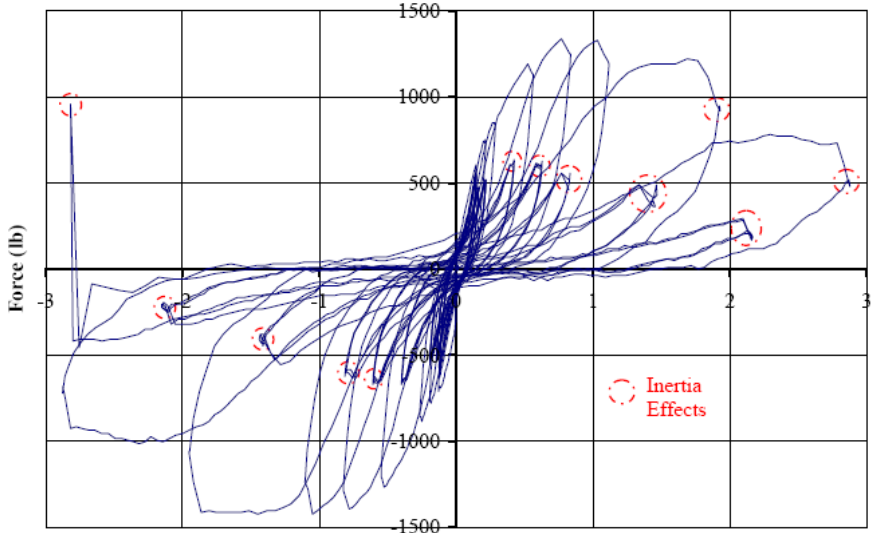
Figure 6. Hysteresis plot for GYPwall